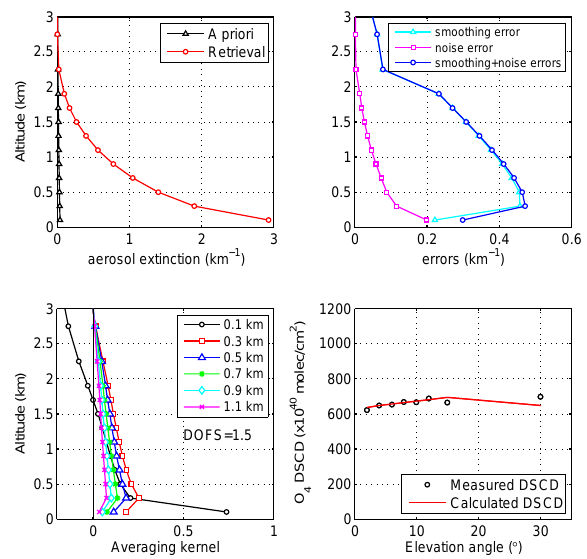
Fig. 4. Same as Figs. 2 and 3 but for aerosol extinction vertical profile retrieved from O 4 DSCDs at 360nm.